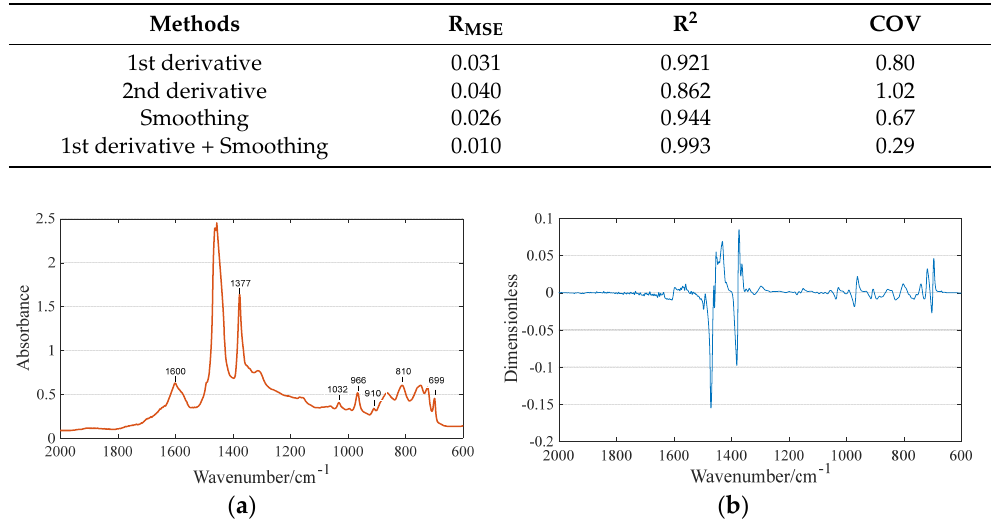
Figure 5. Infrared spectrum of SBS modified asphalt. The spectrum before ( a )and after ( b ) pro ‐ cessing.